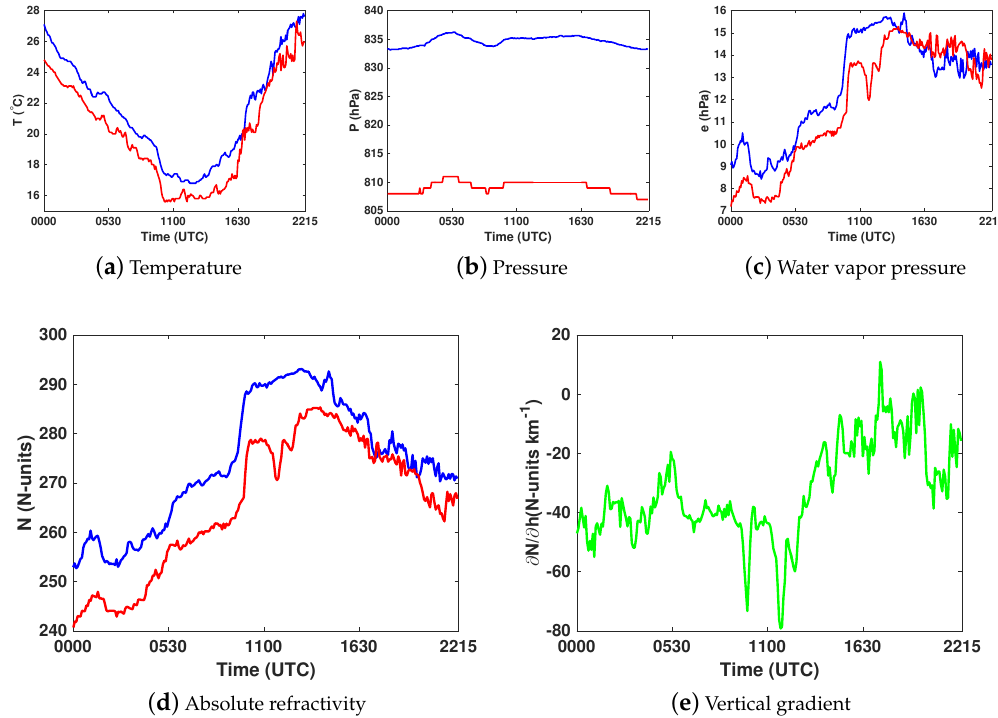
Figure 4. ( a – c ) meteorological observations; ( d ) refractivity derived from automatic weather stations (blue and red lines represent data from Foothills and Mesa weather stations, respectively); ( e ) refractivity vertical gradient estimated from the difference in refractivity measurements at the Mesa and Foothills